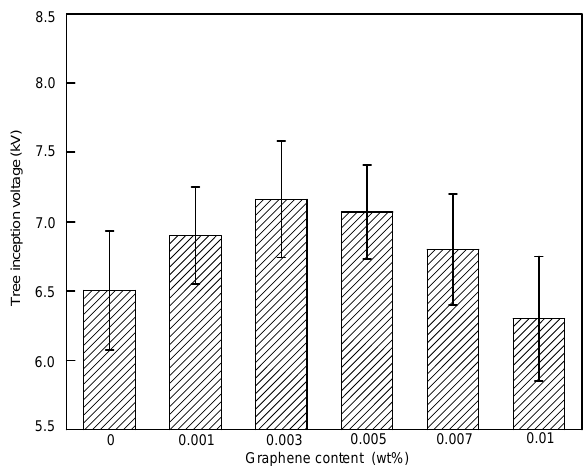
ff erent graphene